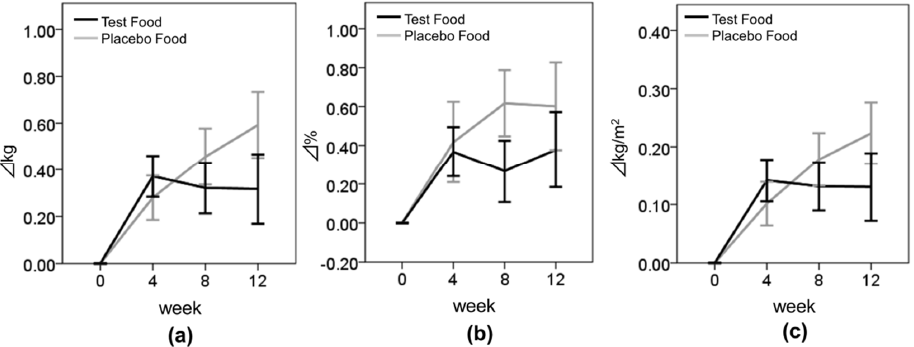
Figure 5. Changes in body composition. Values are means ± standard errors (SEs). ( a ) BW; ( b ) BFR; and ( c ) BMI. Black bar, test group; Gray bar, placebo group.